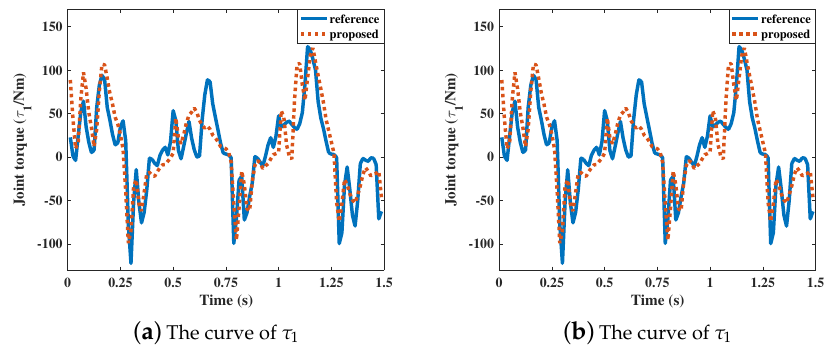
Figure 15. Joint torques of the RF leg in the SCalf prototype experiments.